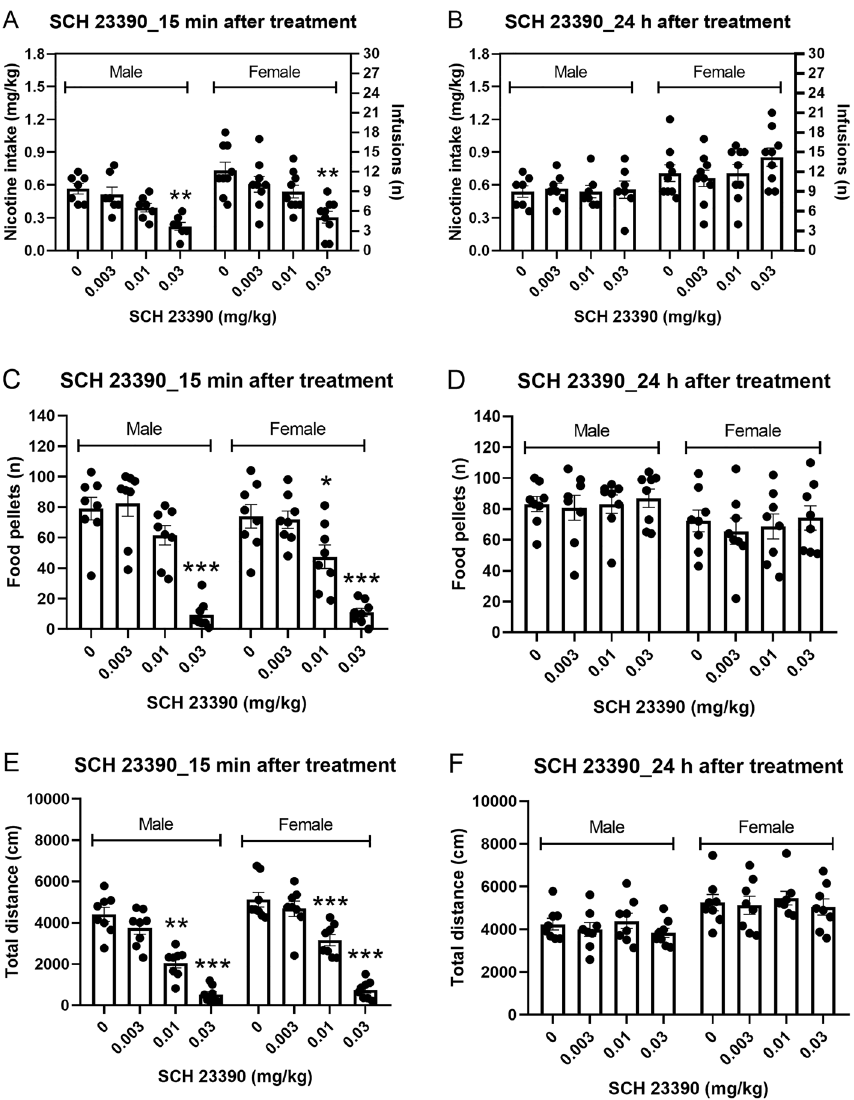
Figure 1. Effects of the D1-like receptor antagonist SCH 23390 on nicotine and food intake and locomotor activity in male and female rats. The effects of SCH 23390 on nicotine ( A 15 min; B 24 h) and food intake ( C 15 min; D 24 h) and locomotor activity ( E 15 min; F 24 h) were investigated. Treatment with SCH 23390 decreased nicotine and food intake and locomotor activity 15 min, but not 24 h, later. Nicotine self- administration (males n = 7, females, n = 9), operant responding for food and small open field test (males n = 8, females, n = 8). Asterisks indicate a significant difference from rats of the same sex that received vehicle. *P < 0.05, **P < 0.01, ***P < 0.001. Data are expressed as means ±